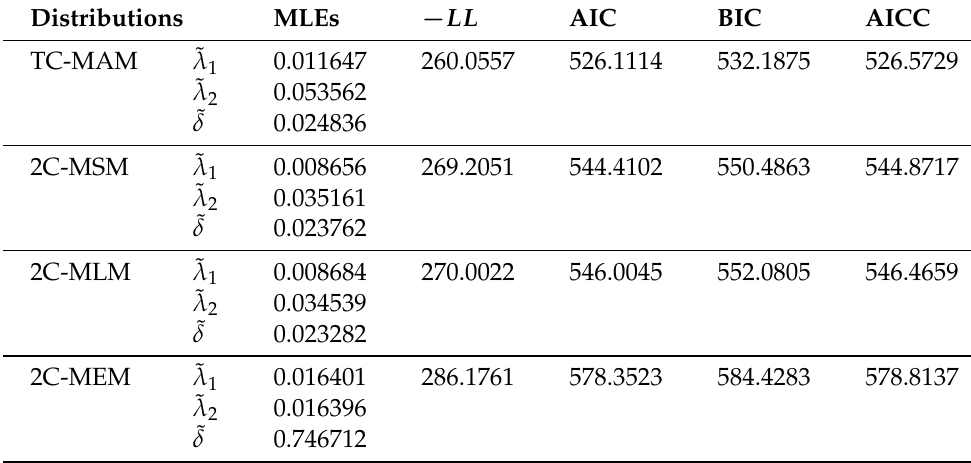
Table 1. MLEs, and GoF statistics for the Dataset